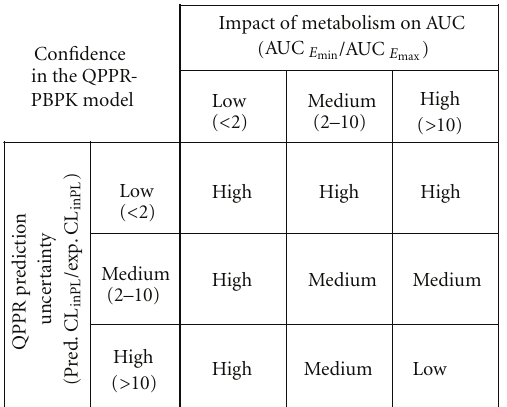
Figure 1: Evaluation of the confidence in applying the QPPR for CL intPL in a PBPK model using a sensitivity/uncertainty approach.